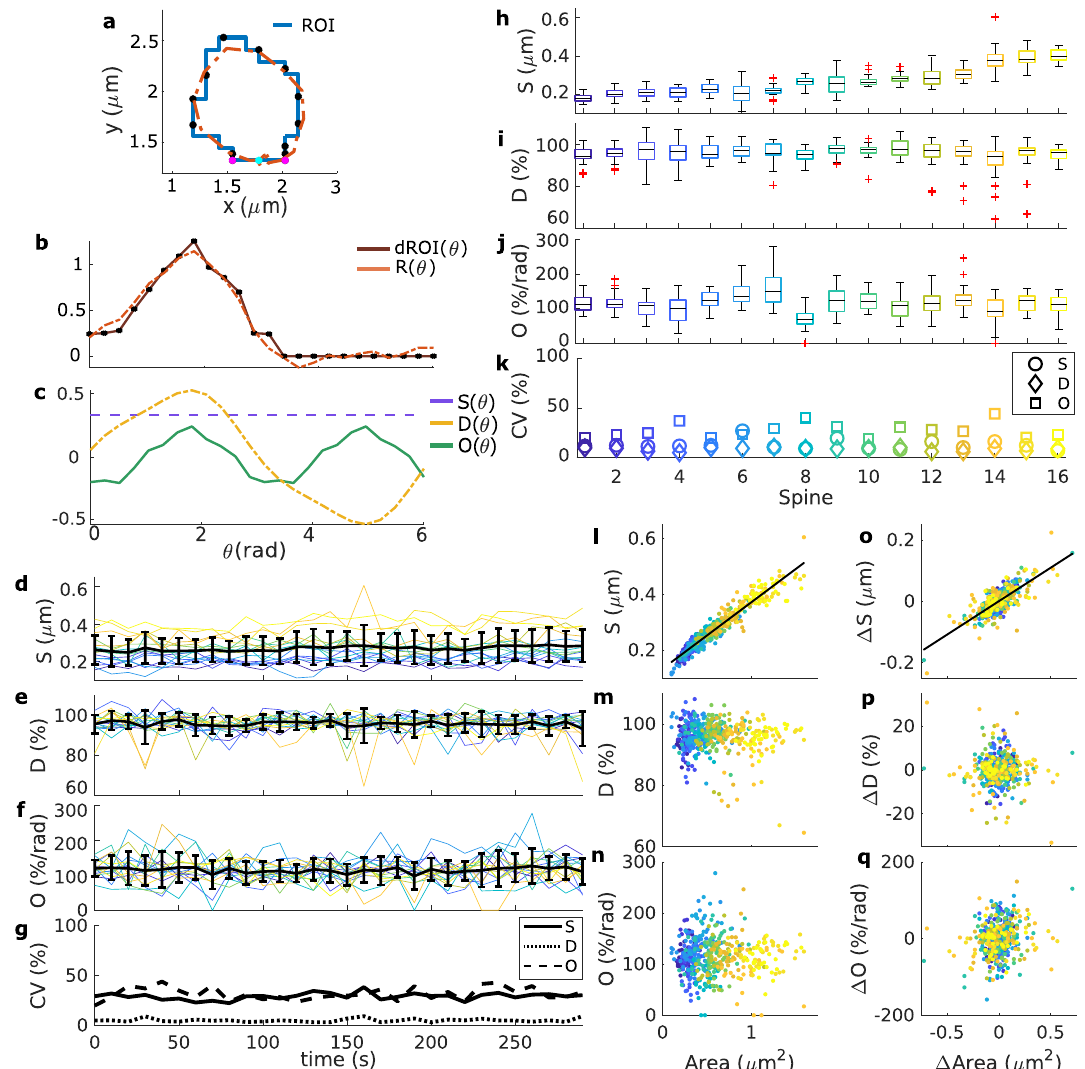
Figure 3. Shape descriptors of spines from a population data set. ( a ) Blue line: ROI extracted from data corresponding to the spine in Fig. 2a at time = 280 s. Black dots correspond to the sampled points of the ROI and the orange dotted line to the approximation function R (θ) . Magenta dot denotes the spine neck center and cyan dots the neck limits. ( b ) Plot of the distance between the neck and sample points dROI (θ) (brown line) and R (θ) (orange line) over the sampling angles θ i (in radians). ( c ) The three parts of R (θ) corresponding to the general size of the spine S (θ) , the directional selectivity D (θ) , and orientational selectivity O (θ) (see “Methods” for details). ( d–f ) Shape descriptors, S , D , and O , evolution over time for different spines. ( g ) Coefficient of variance corresponding to ( d – f ). ( h–j ) Box plot of shape descriptors for the analyzed spines, color-coded as in Fig. 2. ( k ) Coefficient of variance of the shape descriptor for each spine. ( l–n ) Spine area against shape descriptors S , D and O , respectively. Each dot represents the corresponding value at a time-frame for a certain spine (color-coded). Black line is a linear least-squares fit. Only S correlates significantly with the area (p-value 0.96 ). ( o–q ) Same as ( l – m ) but using the time differences of < 0.01 ; Pearson’s linear correlation coefficient cc = 0.77 the shape descriptors. (cid:31) S correlates with (cid:31) Area (cc =